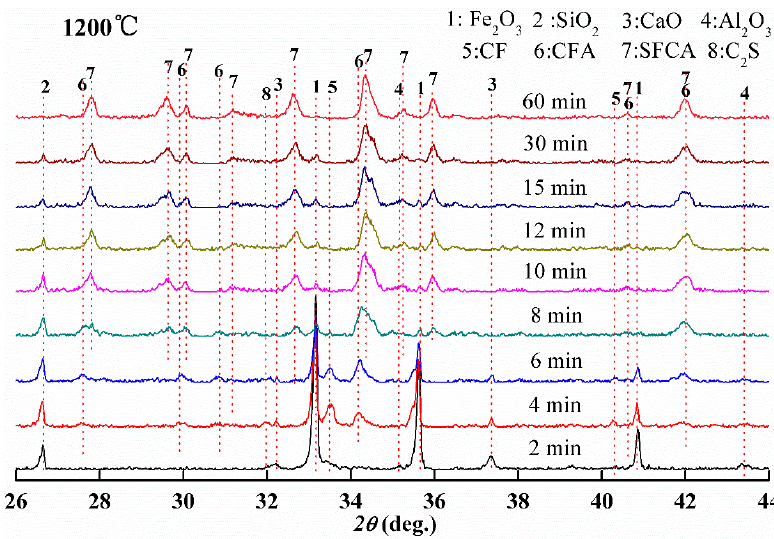
Figure 8. XRD patterns of sample C sintered at 1200 °C at different times by solid-state reactions.